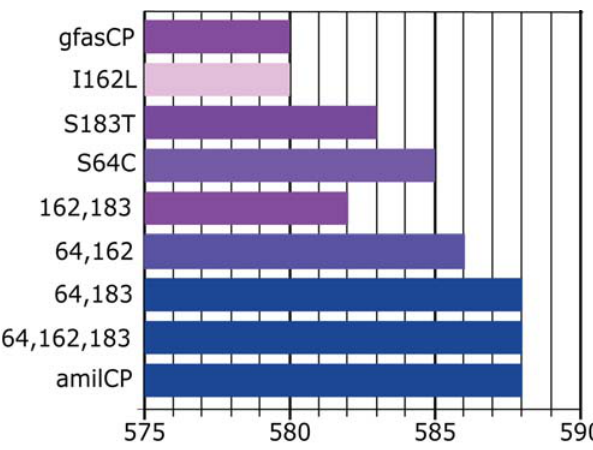
Figure 4. Positions of emission maxima in the mutated purple chromoprotein gfasCP in comparison to the blue amilCP. Horizontal axis is wavelength in nanometers, the bars indicate the position of the absorption peak in the mutant. The colors of the bars approximately correspond to the colors of the mutants. Mutations S64C and S183T were found to be responsible for the blue color in amilCP (numeration according to GFP). Mutation I162L results in a very slowly maturing protein, hence pale color of the corresponding bar. This effect is rescued by any of the other two mutations.